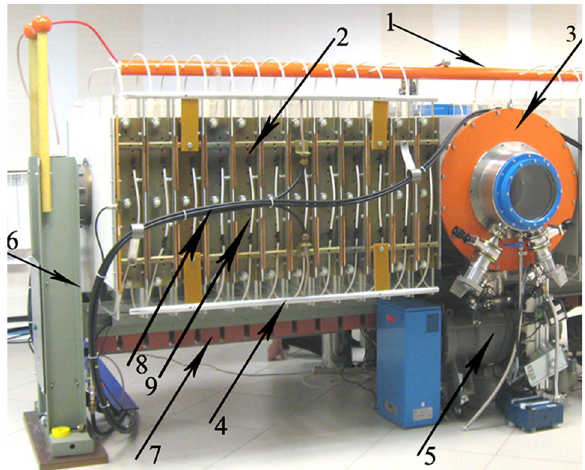
FIG. 8. Partial view of the generator (one LTD and central vacuum chamber): 1—charging bus; 2—transformer stage; 3—vacuum chamber; 4—triggering bus; 5—vacuum pump; 6—support; 7—capacitors of the premagnetization block; 8—triggering cables; 9—air purge system of the transformer stage